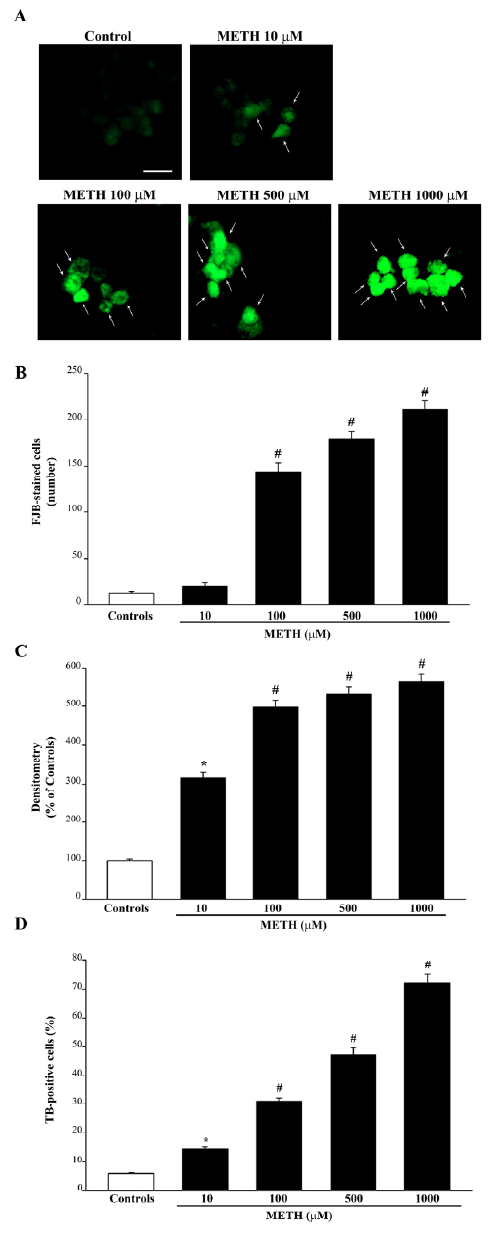
Figure 2. METH dose-dependently increases FJB histofluorescence and TB-positive cells. ( A ) Repre- sentative pictures of FJB-stained PC12 cells after treatment with increasing doses (from 10 µ M up to 1000 µ M) of METH show a dose-dependent increase in FJB histofluorescence induced by METH compared with controls. Arrows indicate FJB intensely positive cells. This is confirmed by the graphs shown in ( B , C ), which report the number of FJB-positive cells and the mean intensity of fluorescence per cell, respectively, both in control conditions and following increasing doses of METH. ( D ) The graph reports the count of TB-positive cells following increasing doses of METH (from 10 µ M up to 1000 µ M) compared with controls. Values are given as the mean ± S.E.M ( B ) the mean percentage ± S.E.M. (assuming controls as 100%, ( C )) or the mean percentage ± S.E.M. of TB-positive cells out of the total cells ( D ), which were counted from three independent experiments. * p ≤ 0.05 compared with controls; # p ≤ 0.05 compared with controls and METH 10 µ M. Scale bar = 14 µ